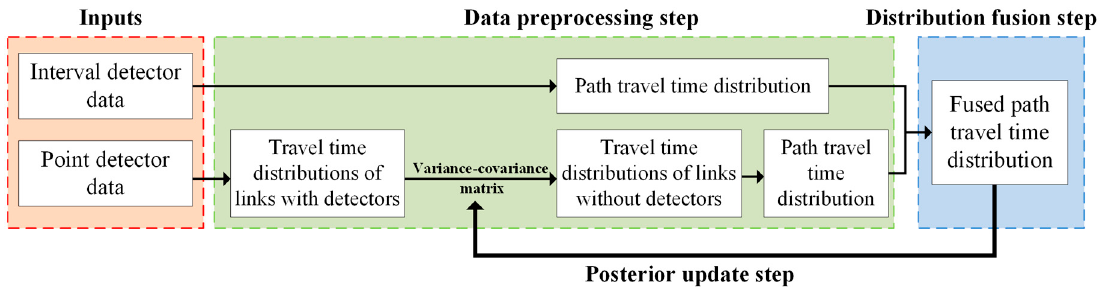
Figure 2. Framework of the proposed heterogeneous data fusion